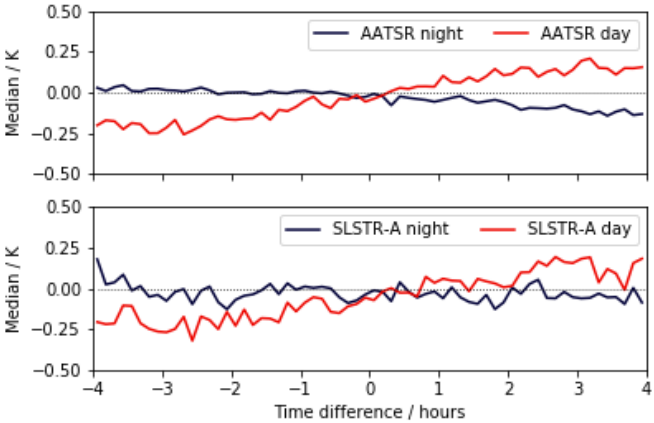
Figure 1. Comparison of (upper) advanced along-track scanning radiometer (AATSR) and (lower) sea and land surface temperature radiometer (SLSTR) dual-view skin sea surface temperature (SST) retrievals with matched in situ radiometer measurements. Median satellite-radiometer SST di ff erence is plotted against satellite-radiometer time di ff erence. The data are binned in time di ff erence intervals of 7.5 min. The noisier appearance of the SLSTR-A curves is due to a lower accumulation of matches during SLSTR-A's shorter lifetime to date.